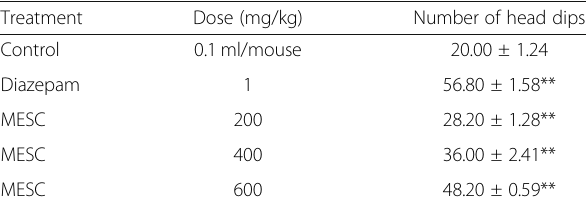
Table 6 The anxiolytic effect of MESC on hole-board test in mice Treatment Dose (mg/kg)